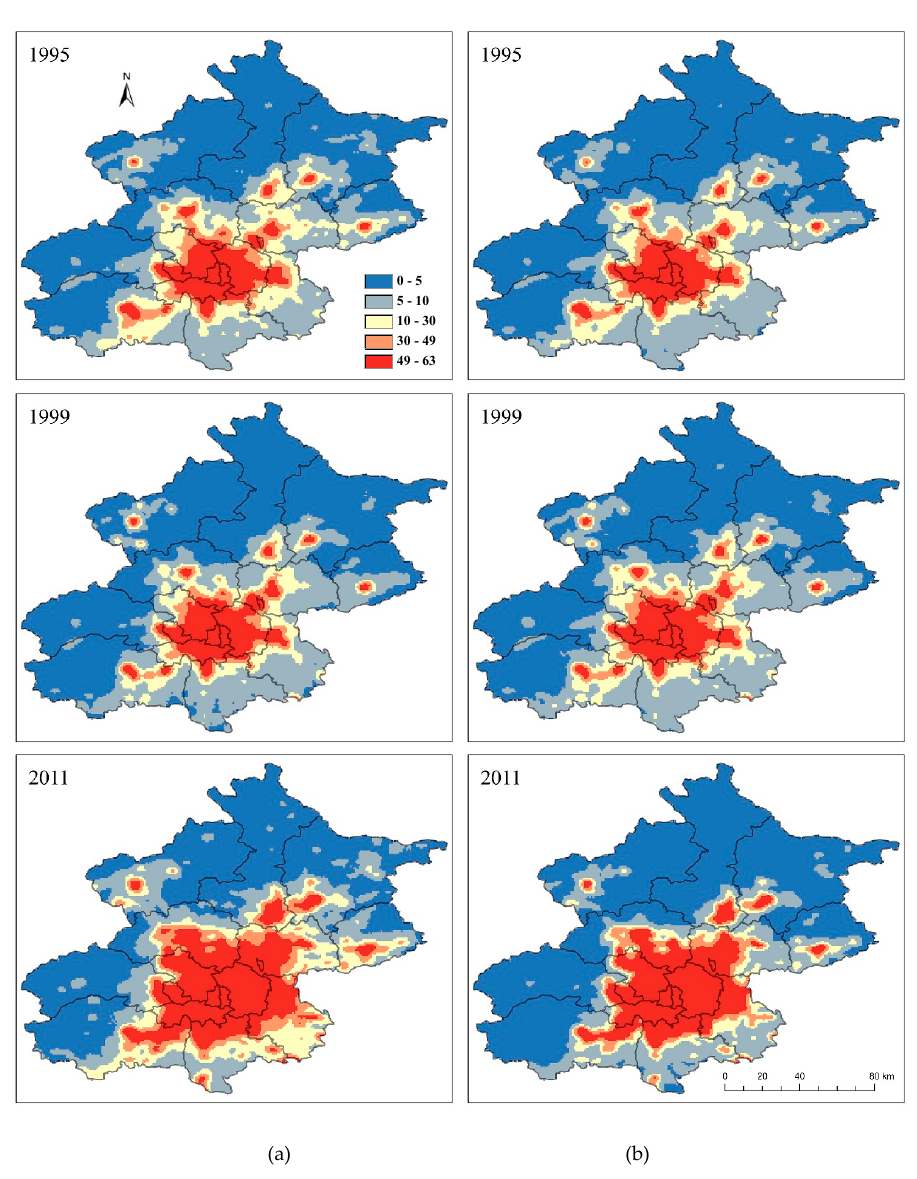
Figure 6. DMSP NTL in Beijing before ( a ) and after ( b ) calibration. Remote Sens. 2019 , 11 , x FOR PEER REVIEW